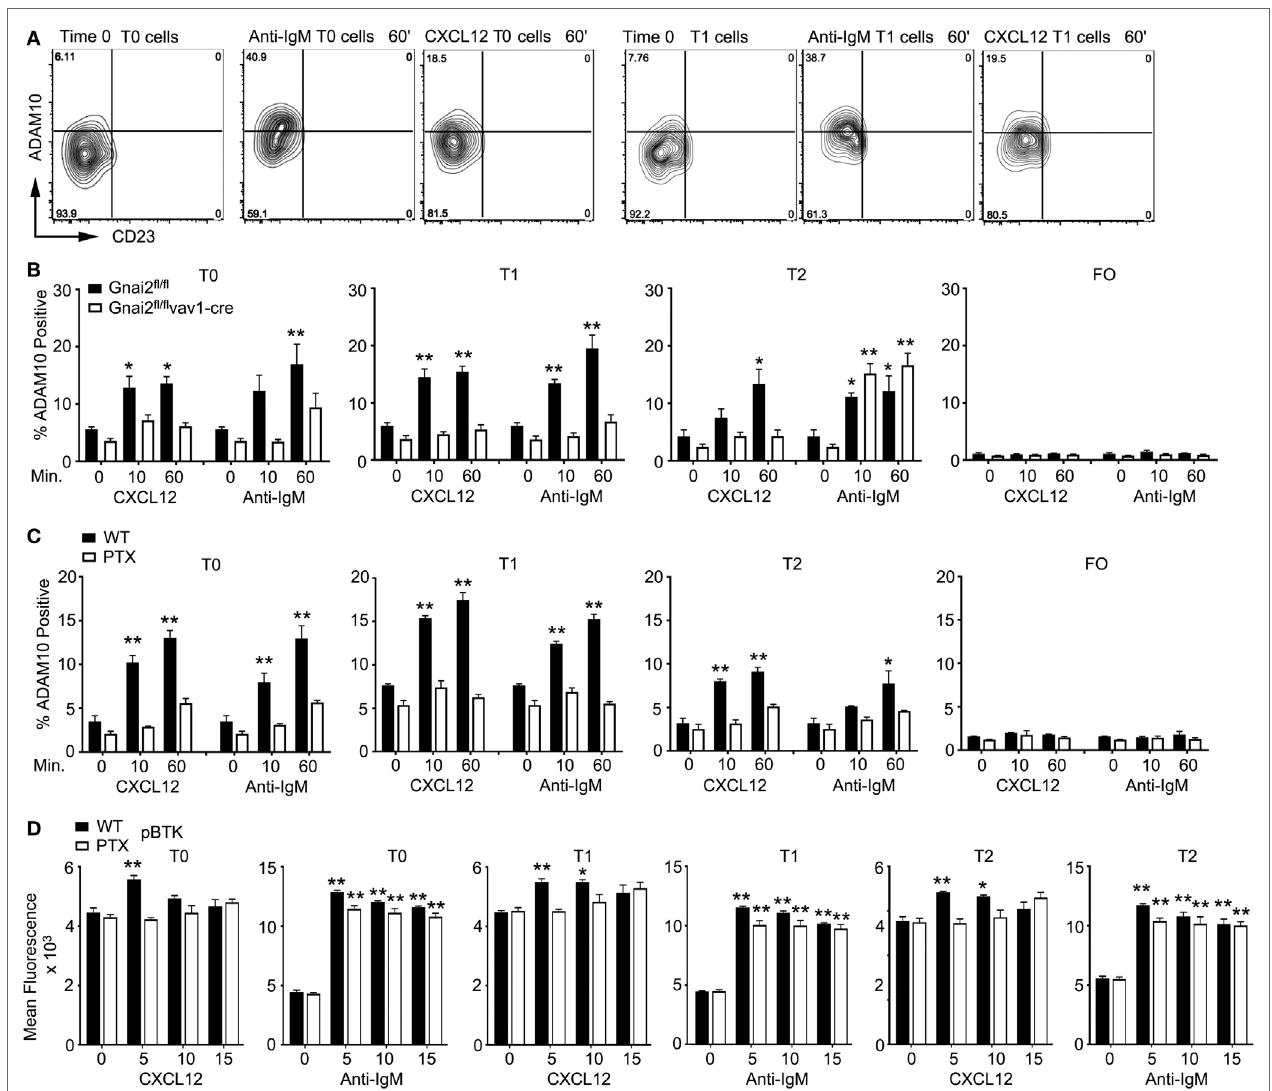
FigUre 6 | Anti-IgM or CXCL12 induces ADAM10 expression on transitional B cell type 0 (T0) and transitional B cell type 1 (T1) B cells. (a) Flow cytometry results examining CD23 versus ADAM10 on T0 and T1 B cells stimulated with anti-IgM or CXCL12. Purified spleen cells equilibrated for 30 min prior to stimulation with 10 µg/ml of anti-IgM F(ab ′ ) 2 or CXCL12 (1 µg/ml) for 1 h prior to analysis. The cells were gated on B220 + CD193 + IgM + CD23 − cell expressing IgD, or not, and the data displayed as ADAM10 versus CD23. (B) Flow cytometry results examining ADAM10 expression on transitional B cells from WT and Gnai2 fl/fl vav1-cre mice. Purified spleen cells from the indicated mice equilibrated for 30 min prior to stimulation with 10 µg/ml of Anti-IgM F(ab ′ ) 2 or Cxcl12 (1 µg/ml) for 1 h prior to analysis. Data shown as % ADAM10 positive on T0, T1, transitional B cell type 2 (T2), or FO B cells. The results are from the analysis of splenic B cells from four Gnai2 fl/fl mice and four Gnai2 fl/fl vav1-cre mice. Data are mean ± SEM (* p < 0.05, ** p < 0.005) (comparison between basal and stimulated). (c) Flow cytometry results examining ADAM10 expression on transitional B cells. Purified spleen B cells were equilibrated for 2 h in media with pertussis toxin (PTX) (200 ng/ml), or not, prior to stimulation with 10 µg/ml of Anti-IgM F(ab ′ ) 2 or CXCL12 (1 µg/ml) for 1 h before analysis. Data shown as % ADAM10 positive on T0, T1, T2, or FO B cells. The results are from the analysis of splenic B cells from three WT mice, which were treated with PTX or not. Data are mean ± SEM (* p < 0.05, ** p < 0.005) (comparison basal versus stimulated). (D) Intracellular flow cytometry to assess phosphorylated Bruton’s tyrosine kinase (pBTK) levels in transitional B treated with PTX or not. The results are from the analysis of splenic B cells from three WT mice, which were treated with PTX or not. Data are mean ± SEM (* p < 0.05, ** p < 0.005) (comparison between basal and stimulated